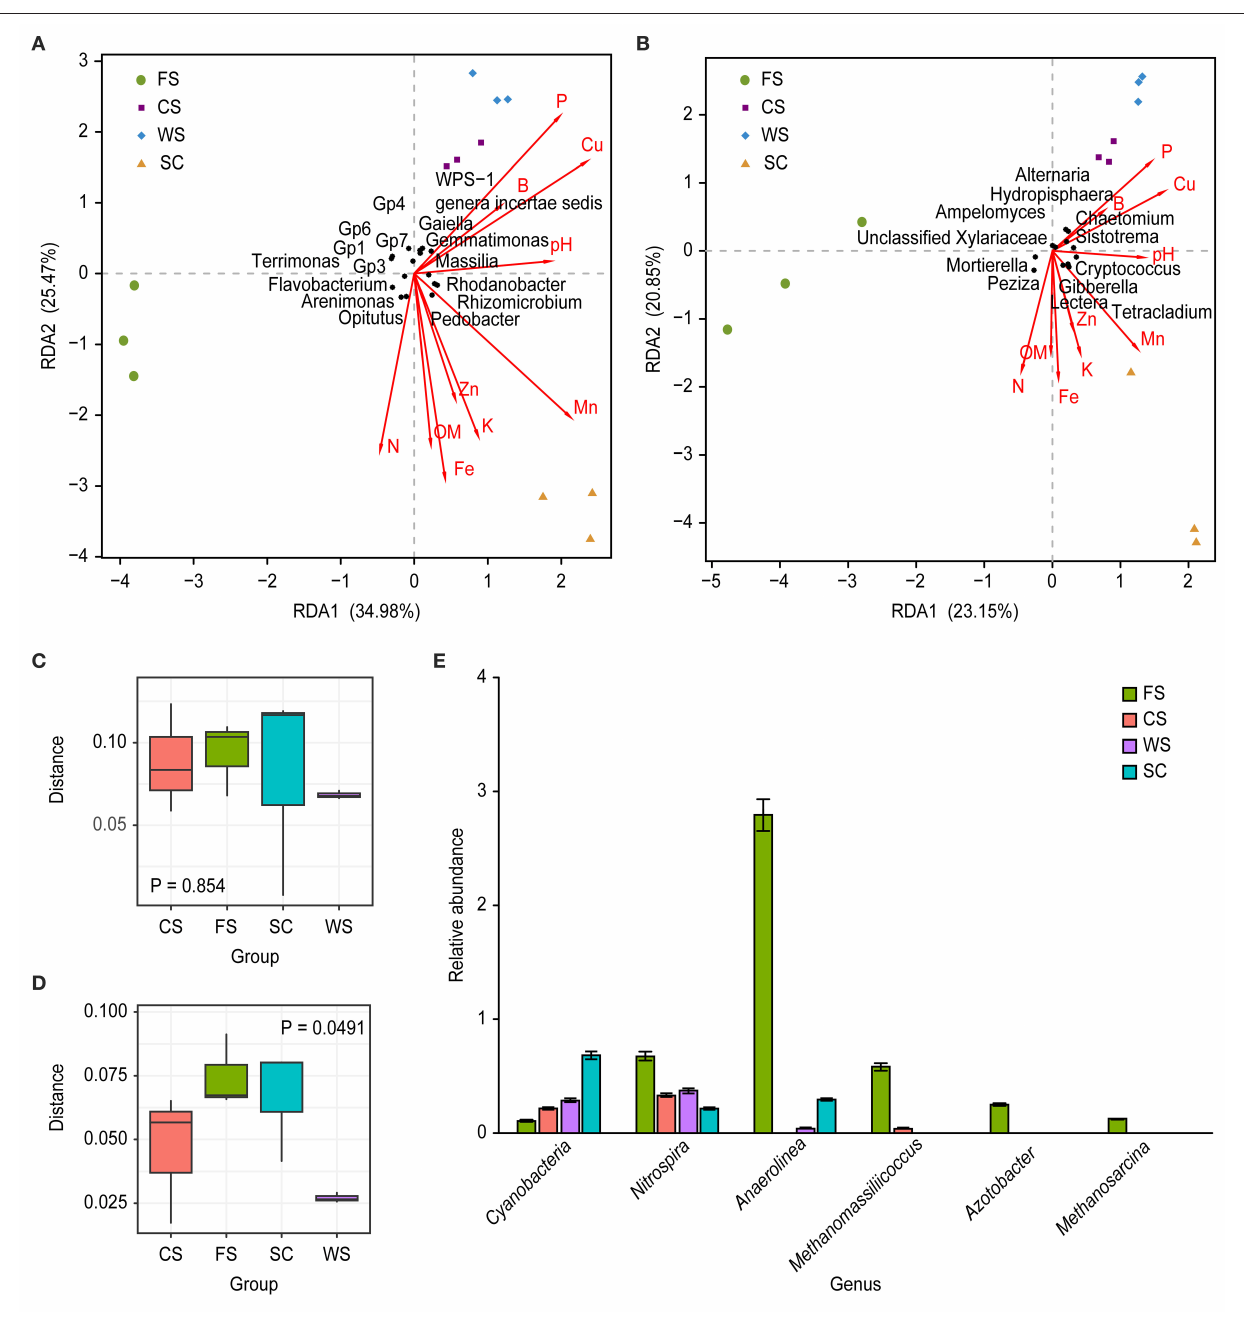
Frontiers in Environmental Science |